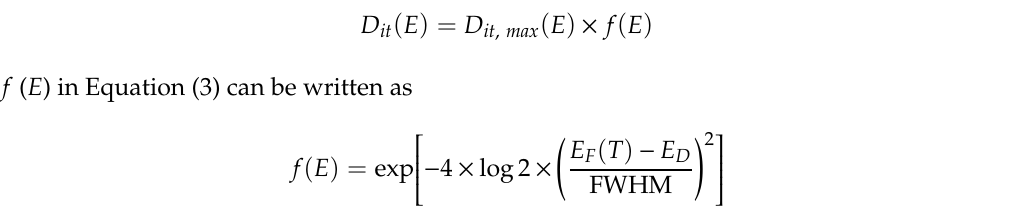
Figure 4. Relationship between SS and temperature for forward sweep ( a ) and backward sweep ( b ), respectively. ( c ) Schematic of Fermi level shifting progress of MoS 2 channel relative to the interface states and conduction band caused by the increasing of temperature from 10 to 310 K for V BG, min of − 50 V. E F, + 50 V and E F, sub correspond to the Fermi level for gate voltage of +50 V and subthreshold voltage, respectively.